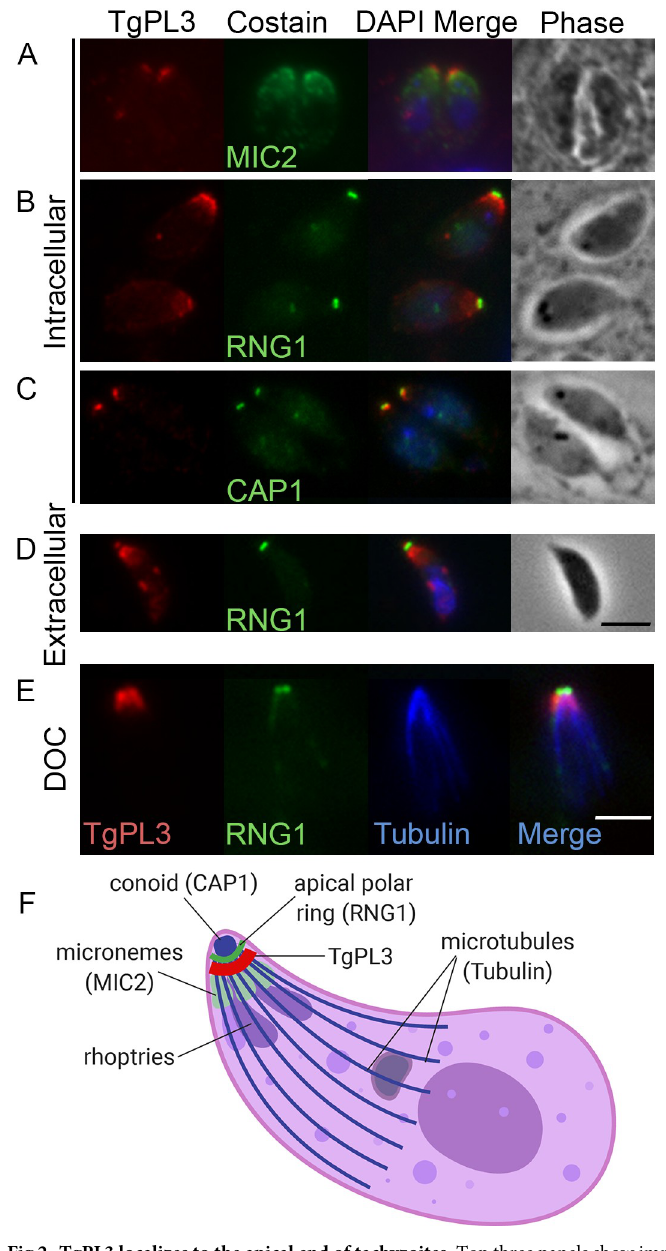
Fig 2. TgPL3 localizes to the apical end of tachyzoites. Top three panels show immunofluorescence of TgPL3 (red) in intracellular tachyzoites co labeled with (A) MIC2, (B) RNG1 or (C) CAP1 (green). Bottom two panels show TgPL3 localization in extracellular tachyzoites after (D) induced conoid extrusion or (E) deoxycholate extraction (DOC). (F) Schematic showing costain localization in intracellular parasites (created with BioRender.com). Images for panels A, B, C and D were taken under the same magnification and the scale bars in the lower right corners equal 5 μ m. Pseudomonas aeruginosa PLP requires ubiquitin or ubiquitinated proteins as cofactor for in vitro activity [20]. To address potential PLA activity for this manuscript, we engineered a 2 TgPL3 complementation construct with TgPL3 containing a single point mutation that changes the predicted catalytic serine in the lipase domain to an alanine (Fig 1B).